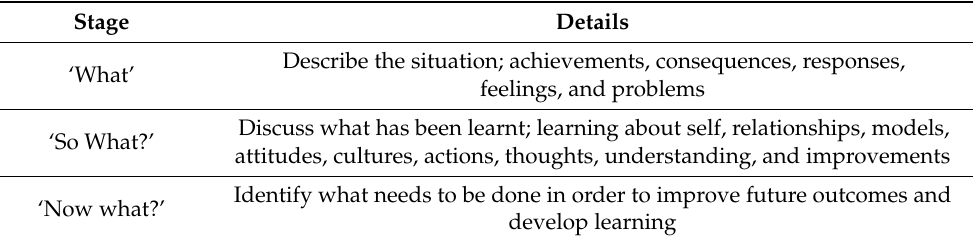
Table 2. ‘What, So What, Now What’ questions. Stage Details Describe the situation; achievements, consequences, responses, ‘What’ feelings, and problems Discuss what has been learnt; learning about self, relationships, models, ‘So What?’ attitudes, cultures, actions, thoughts, understanding, and improvements Identify what needs to be done in order to improve future outcomes and ‘Now what?’ develop